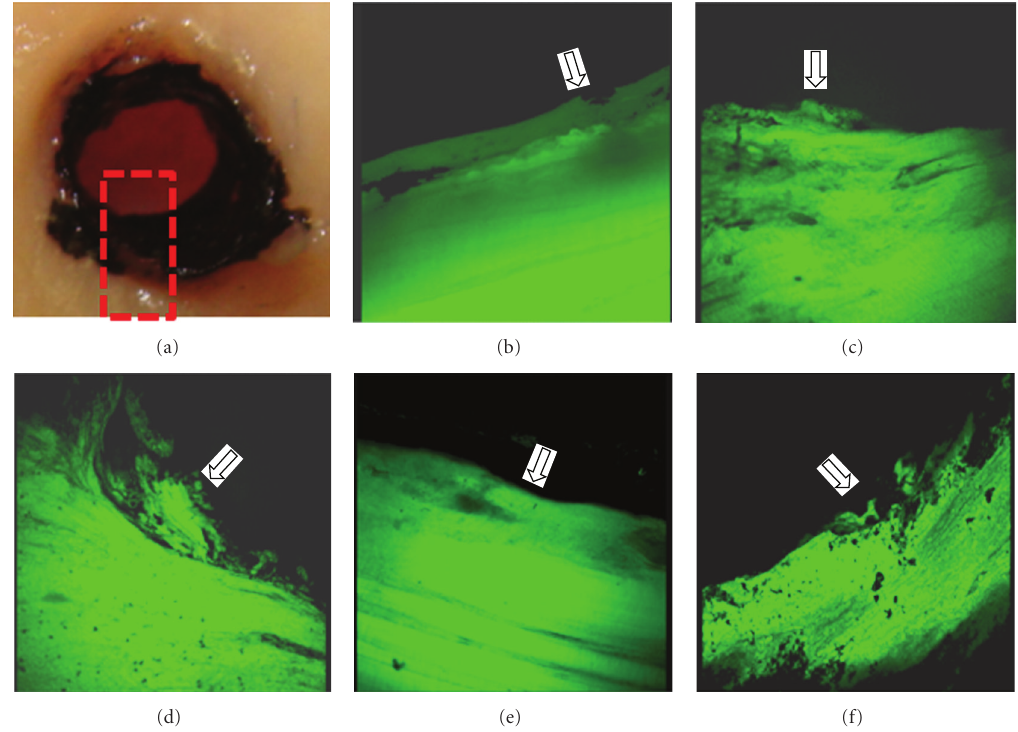
Figure 4: Microscopic structures of the damaged tendon tissues. (a) The rectangular area illustrated where the tendon tissues were sampled for frozen sectioning and confocal microscopy. (b) to (f) Representative microscopic structures of the tendons damaged by the Healix Peek anchor (b), the Fastin RC anchor (c), the Bio-Corkscrew Suture anchor (d), the Healix Transtend anchor inserted through the Percannula system (e), and the Healix Transtend anchor inserted without any cannula (f). Orientation of the photographs: top, edge of the damaged tendon (arrows); bottom, toward the normal part of the tendon. The green fluorescence was the autofluorescence of the tendon fibers. Original magnification,